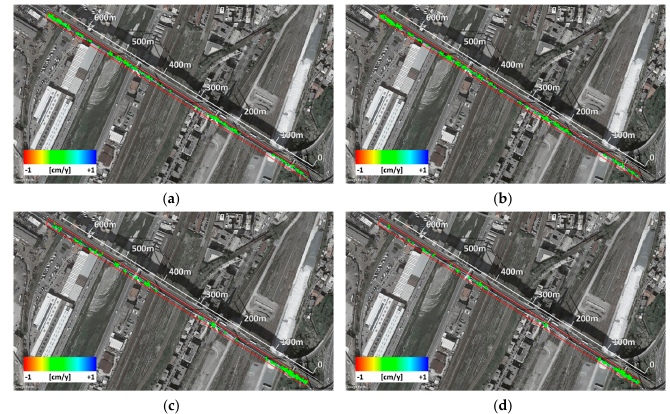
Figure 9. Highlight on the measurement points located within the red frame, corresponding to the southern roadway for ( a ) SBAS and ( b ) TomoSAR processing results related to the ascending dataset, ( c ) SBAS and ( d ) TomoSAR results relevant to the descending dataset. Colormap is set according to the estimated velocity with the convention that negative values correspond to departure from the sensor along the LOS. The white graduated axis represents the longitudinal coordinate of the red rectangle whose origin is set at the southern/eastern end of the bridge.